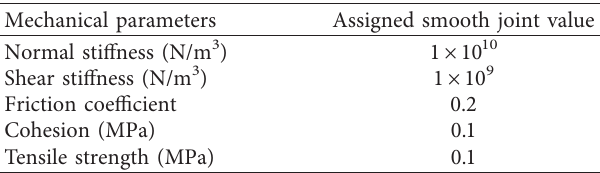
Figure 3: The numerical shear model for calibration tests (blue line represents parallel-bond contact and the green line represents smooth joint contact). Table 3: Mechanical parameters selected for the smooth joint contact